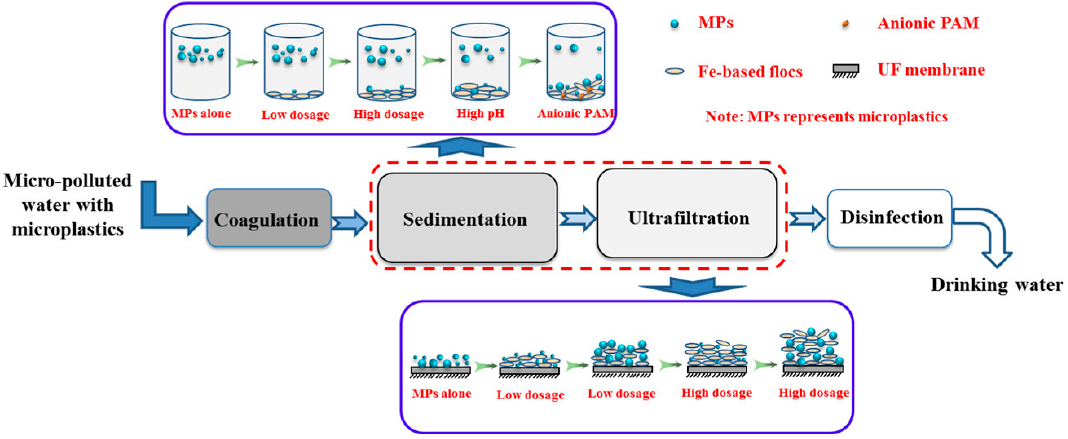
Figure 3. Schematic diagram of microplastics during the coagulation and ultrafiltration processes [43]. MP, microplastic; PAM, polyacrylamide; UF, ultrafiltration. (Reprinted with permission from [43]. Copyright 2017 Elsev.).